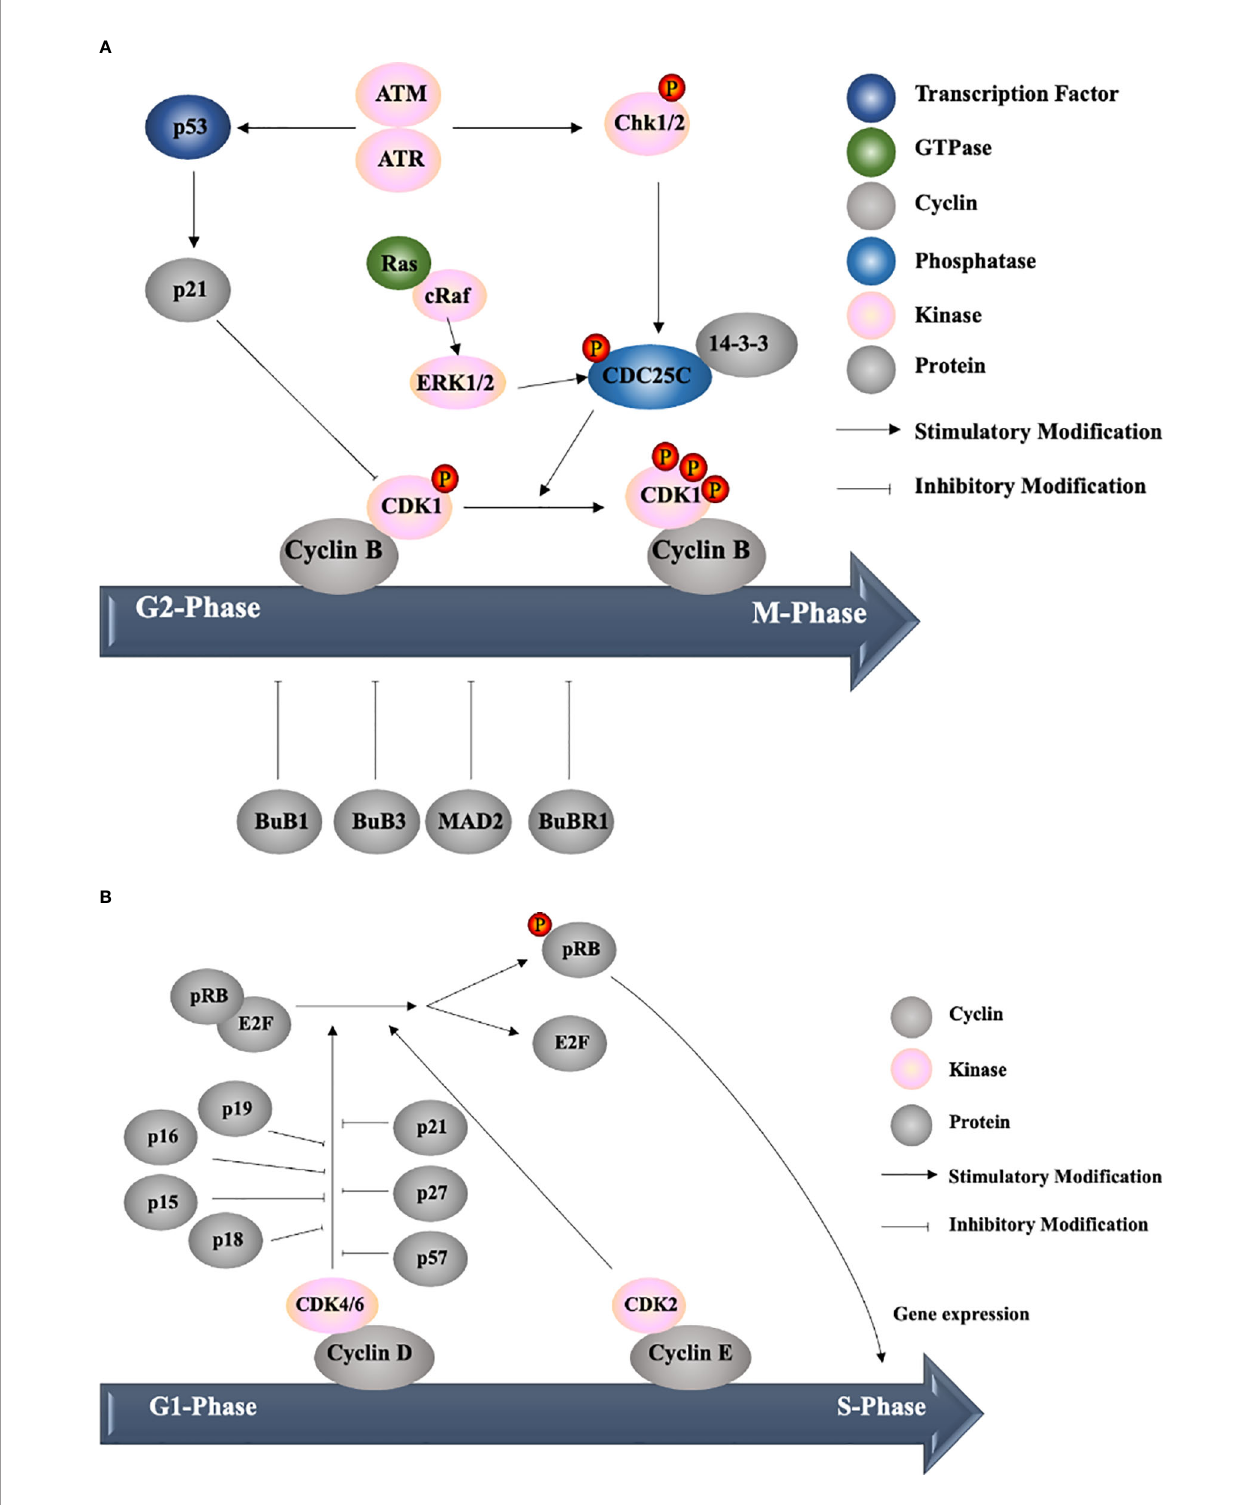
FIGURE 2 | Cell cycle progression. (A) Example of targets of cell cycle arrest at the G2/M transition and G1/S transition in tumor cells for the development of liver cancer drugs. ATM, ataxia telangiectasia mutated; ATR, ATM and Rad3-related; Chk, human checkpoint kinase; ERK, extracellular signal-regulated kinase. (B) Example of targets of cell cycle arrest at the G1/S transition in tumor cells for the development of liver cancer drugs. pRB, retinoblastoma protein; CDK, cyclin- dependent